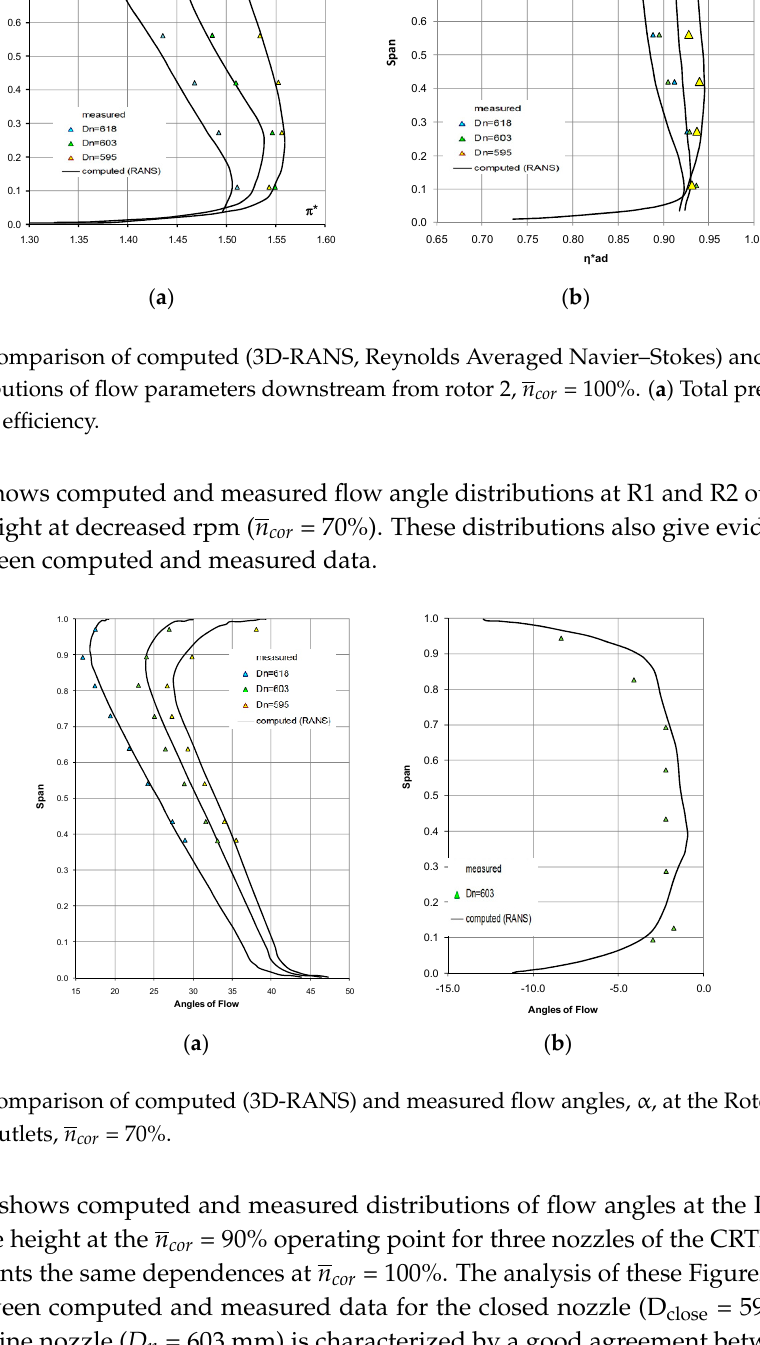
(D open = 618 mm), the comparison shows an acceptable agreement between computed and measured data at both speeds ( (cid:1866)(cid:3364) cor = 90% and (cid:1866)(cid:3364) cor = 100%). For this case, the maximum difference between computed and measured data was 2–3 degrees.